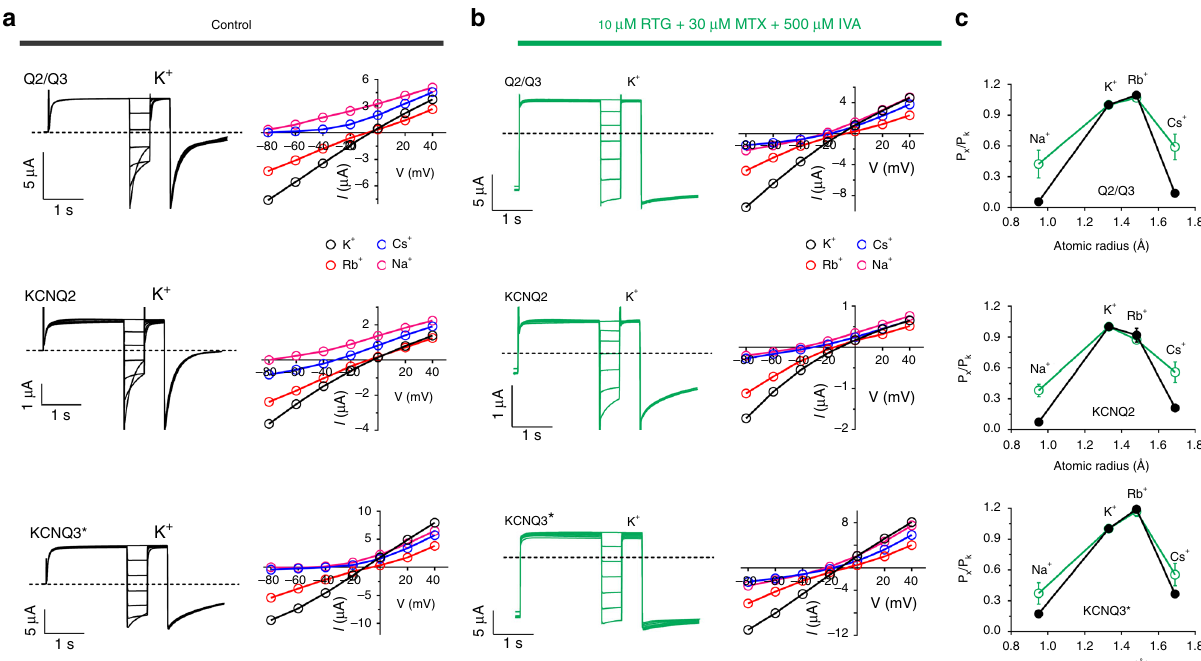
Fig. 8 RTG + MTX + IVA alter the pore conformation of KCNQ2 and KCNQ3. a , b Left , exemplar traces; right , mean I / V relationships for KCNQ2/3